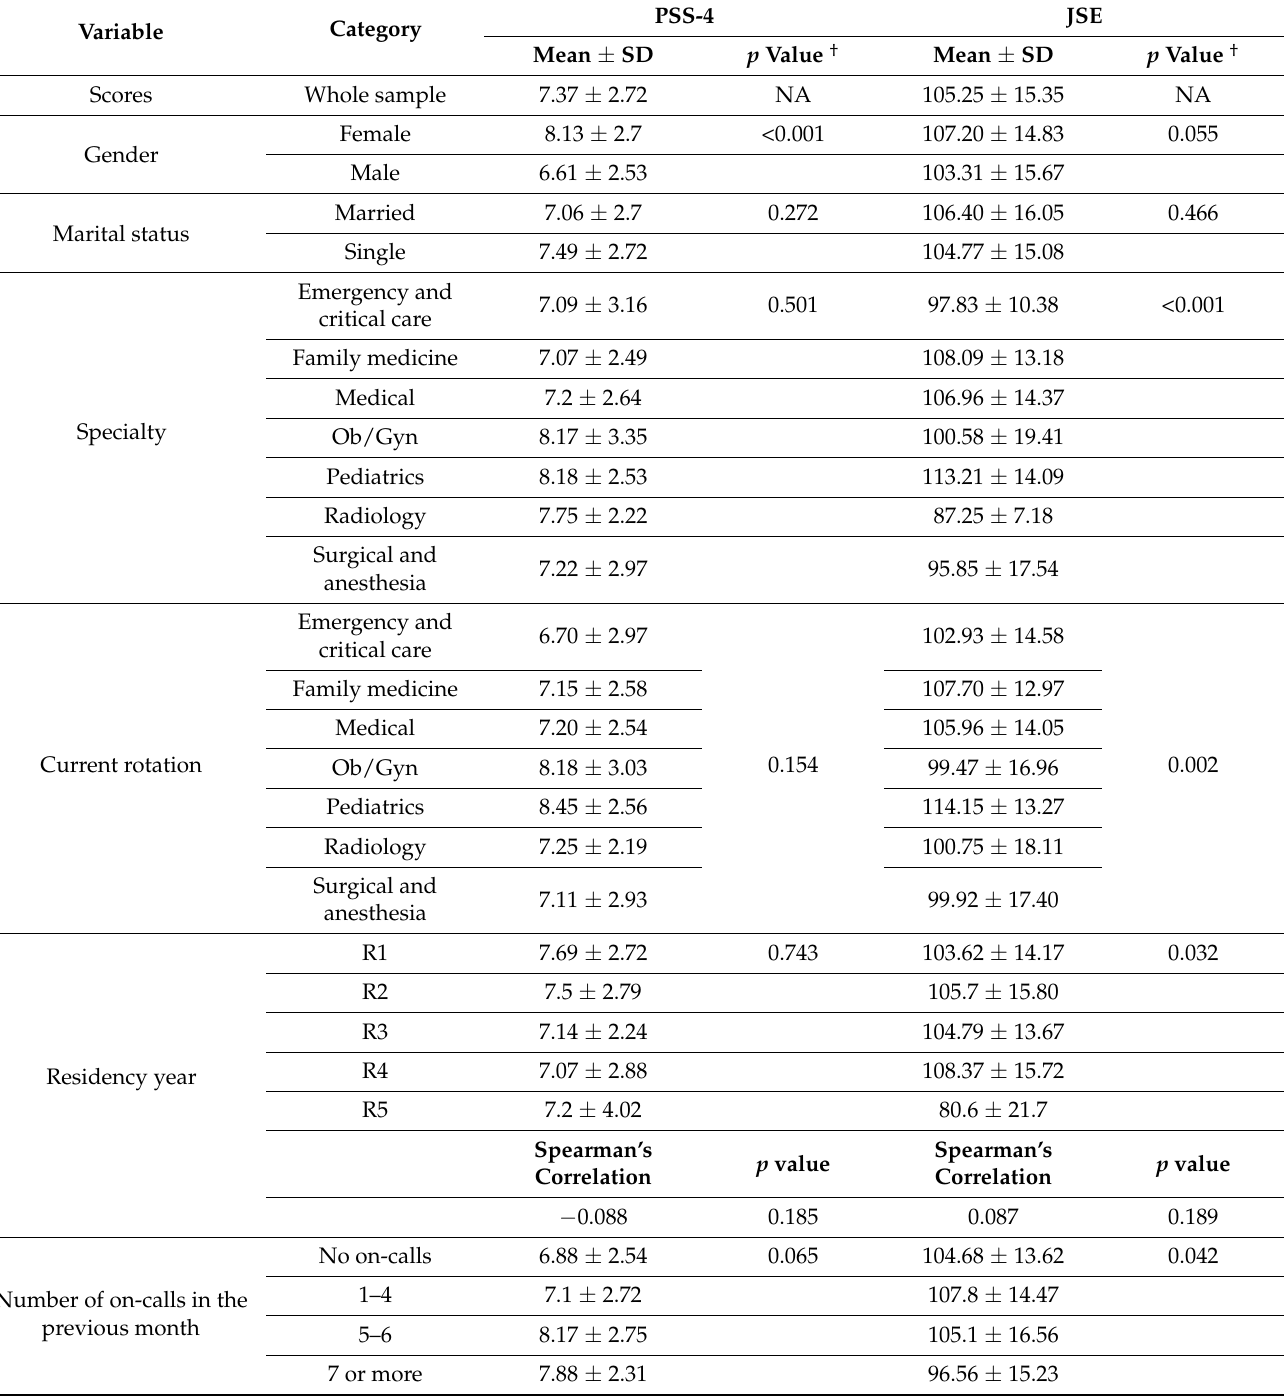
Table 2. Mean scores and correlation coefficients of PSS-4 and JSE scores across the sociodemographic, residency-related, and workload characteristics of residents ( n =